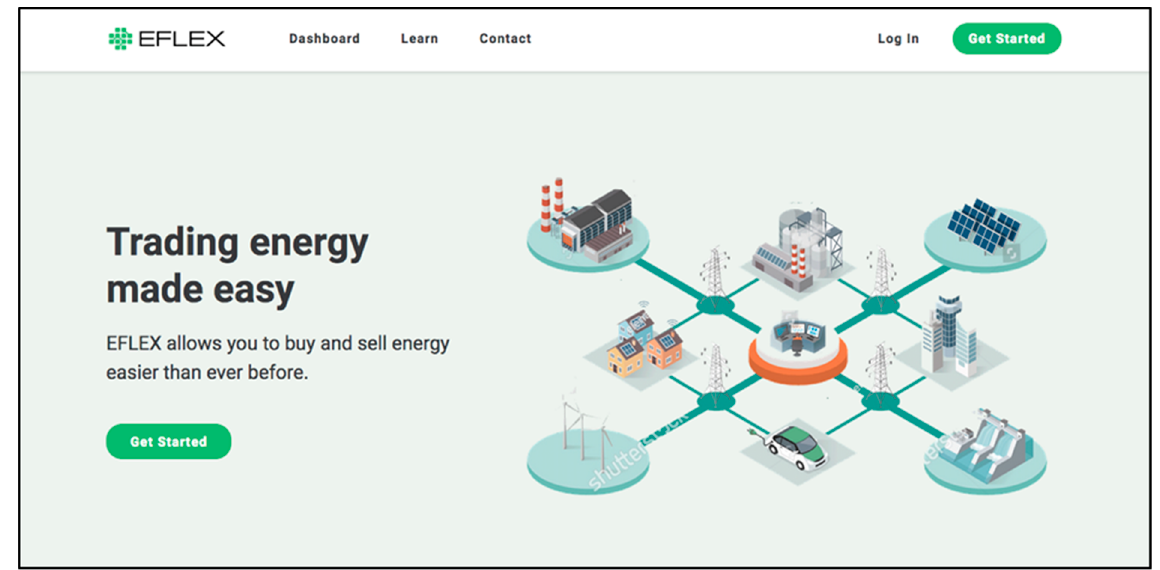
Figure 18. Metamask configuration to start using Blockchain.